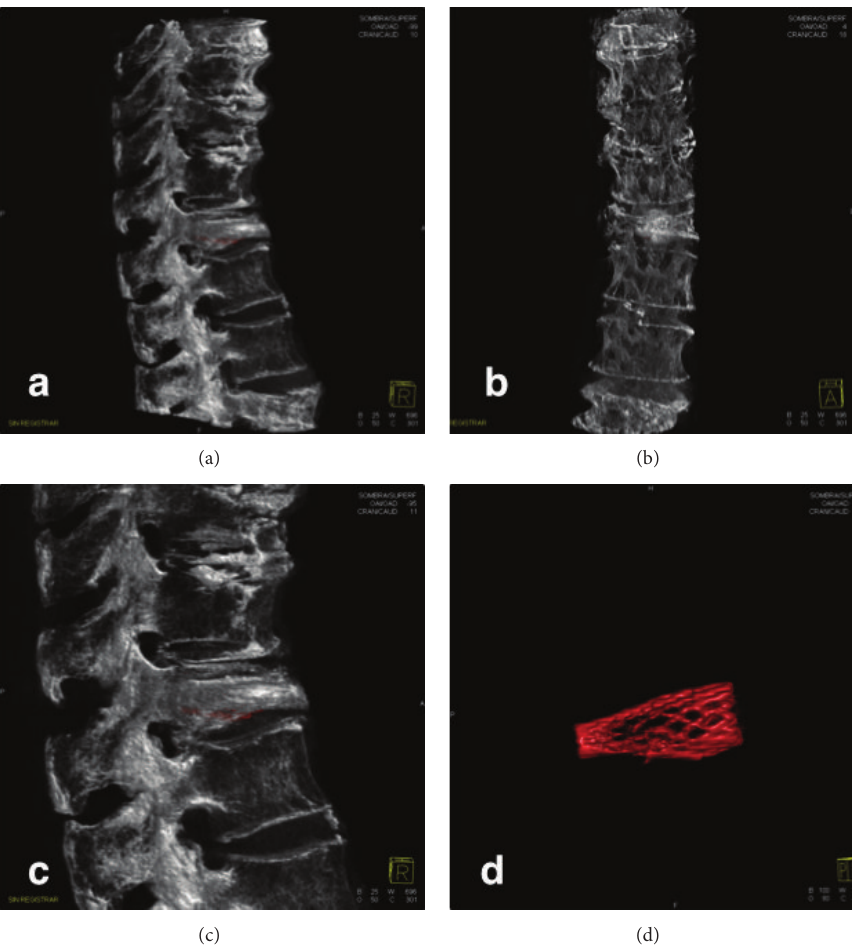
Figure 6: Flat panel detector computed tomography allowed visualization of the disposal of cement inside the affected vertebrae in all angles ((a), (b), and (c)) and the detailed characterization of the intravertebral device